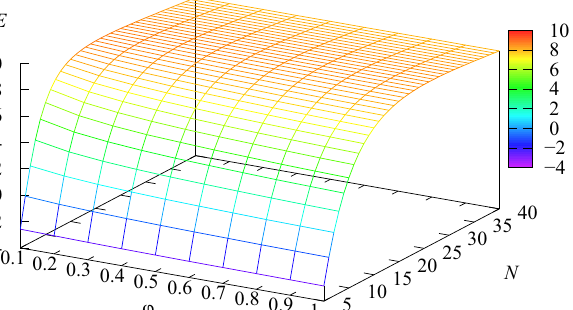
Figure 10. Dependence of the profit function E ( N ) on the number of servers N and the impatience rate ϕ .